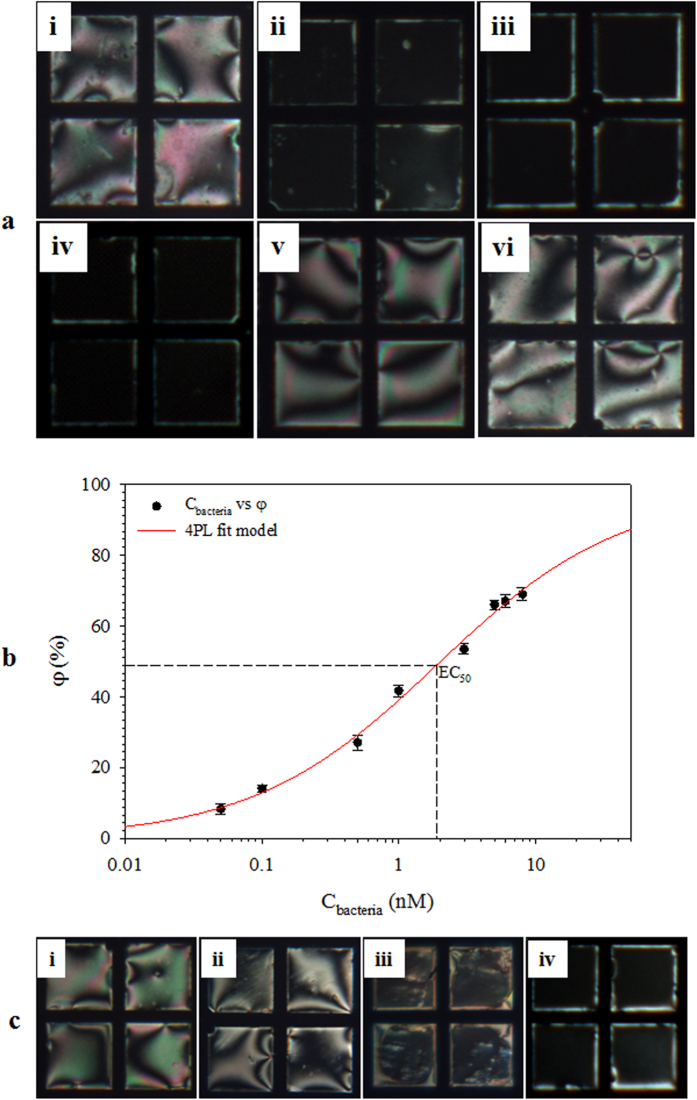
(a) Polarized optical microscopy images of TEMDTAB/DNAs at Tm = 52.4 °C, functionalized with F27 in 5 mM NaCl solutions of (i) ssDNAbc and (ii) thermally degraded ssDNAbc; with (iii) ITS1 and (iv) ITS 4 in a 5 mM NaCl solution of ssDNAfg; with (v) ITS1 in a 10 nM dsDNAfg solution; and with (vi) a random 16-mer 5′-AACGGGACTCGGGAGA-3′ oligomer in a 5 mM NaCl solution of the thermally degraded ssDNAbc. (b) The loss of brightness (φ) as a function of Cbacteria, the error bars represent standard deviation and (c) TEMDTAB/DNA in a mixture solution of human serum with ssDNAbc contents of (i) 0, (ii) 0.5, (iii) 3, and (iv) 6 nM. F27, ssDNA oligomer complementary to Erwinia carotovora DNA; ITS1/ITS4, universal primers; ssDNAbc, genomic DNA of Erwinia carotovora; ssDNAfg; genomic DNA of Rhazictonia solani; TEMDTAB/DNAs, liquid-crystal-filled transmission electron microscopy grids coated with dodecyltrimethylammonium bromide (DTAB) and ssDNAprobe; Tm, temperature at which 50% of the nucleotide anneals.